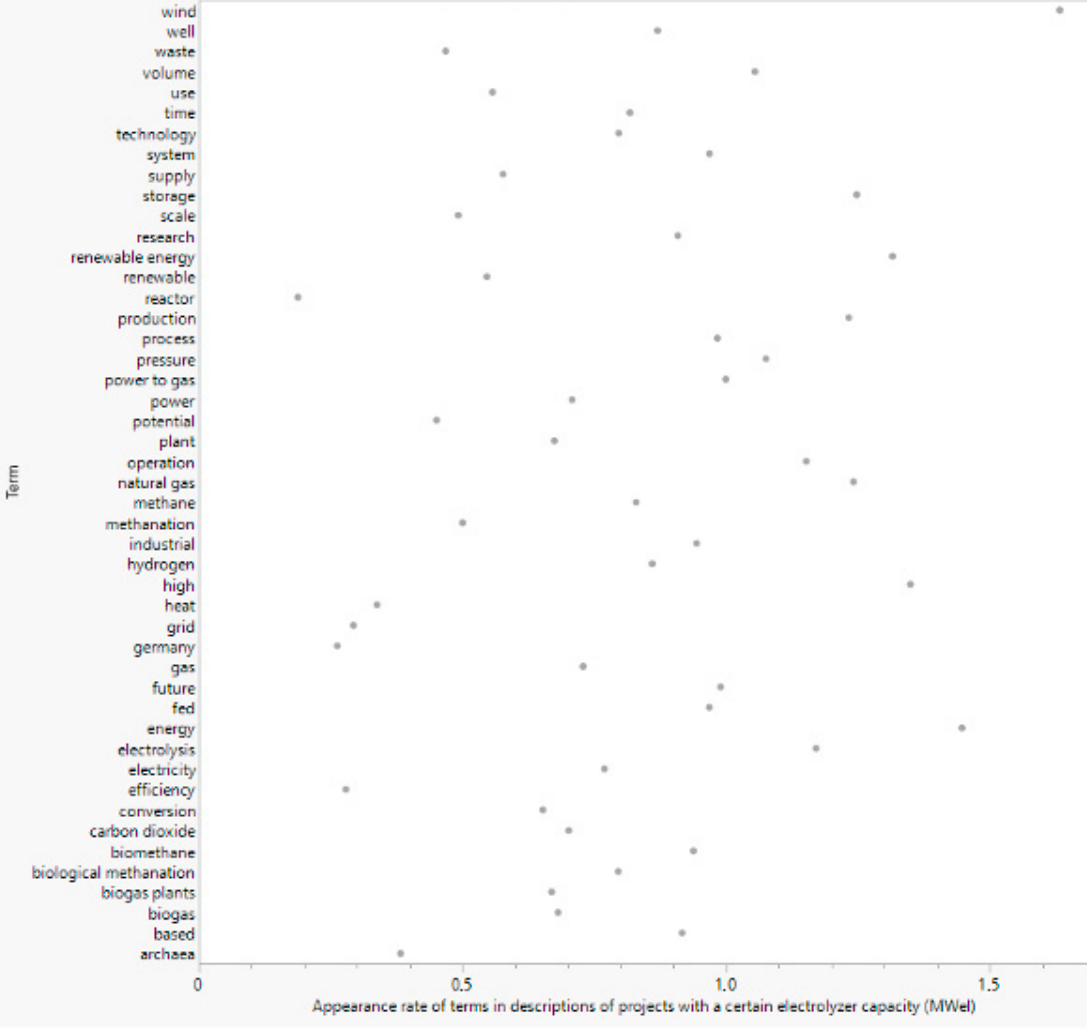
Figure 4. Appearance of the most common terms according to the size of the planned/implemented biomethanation facility. For example, the term “storage” appeared in project descriptions of biomethanation plants, which were 1.3 MW el on average.